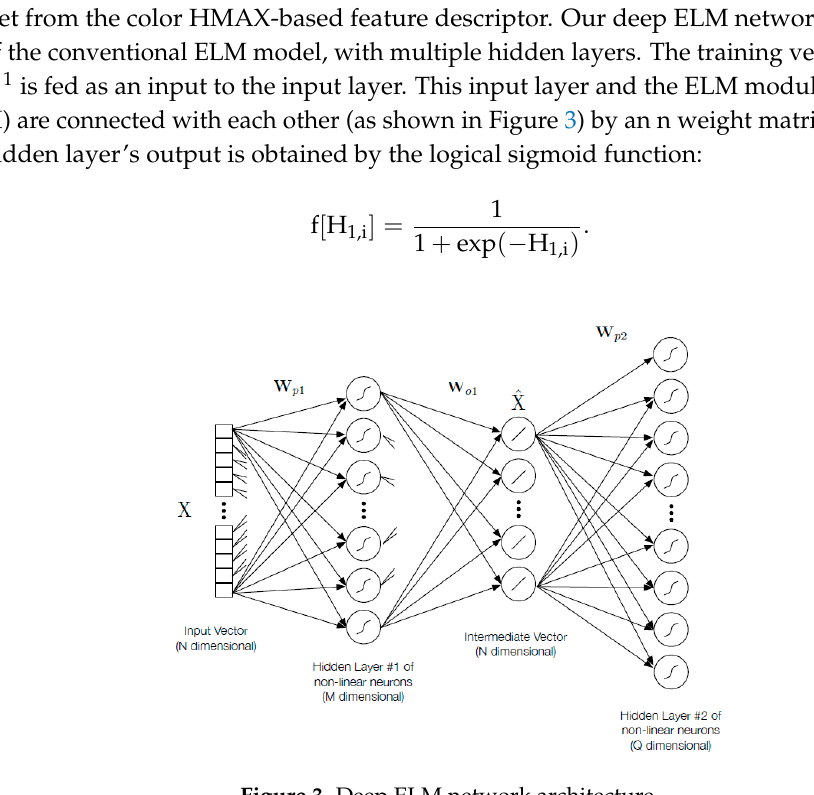
Figure 3. Deep ELM network architecture.